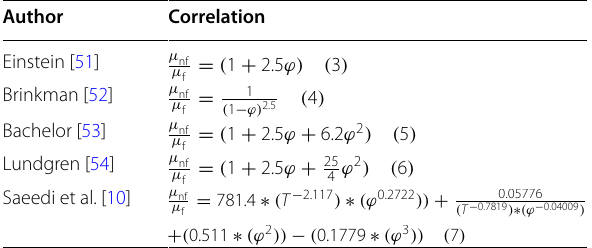
Table 5 Proposed relations of relative viscosity